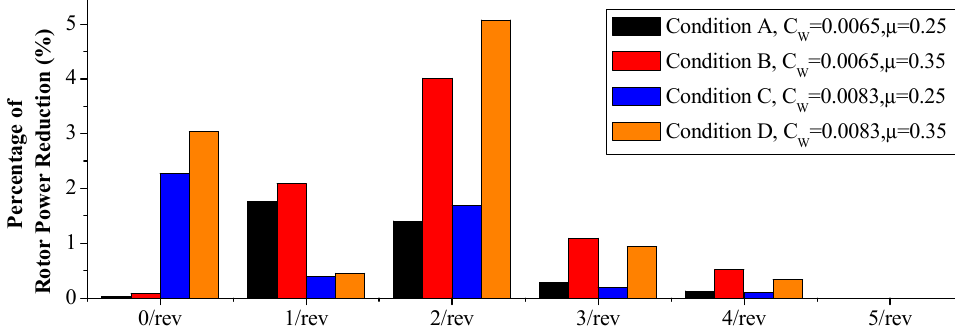
Figure 9. Rotor power reduction using uniform twist control with single-harmonic inputs. Table 3. Rotor power reduction using uniform twist control with single-harmonic inputs. Condition